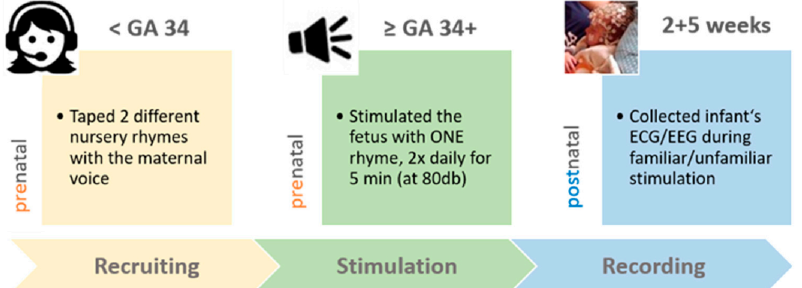
Figure 1. Experimental procedure. Mothers-to-be ( n = 34; fetus < GA34) taped two di ff erent nursery rhymes during a visit in our laboratory and were afterwards assigned (randomly) to two groups. In the experimental group (EG, n = 22), one nursery rhyme was replayed to the fetus (80 dB over loudspeakers; presented twice daily for five minutes) the last six weeks ( > GA34) until birth. In the control group (CG, n = 12), fetuses were not stimulated with any rhyme. After birth (two and again five weeks) EG and CG infants’ electrocardiography (ECG) and high-density electroencephalography ( hd EEG) were collected during auditory stimulation with both rhymes presented with both voices, namely the familiar (maternal) and an unfamiliar female voice. GA = gestational